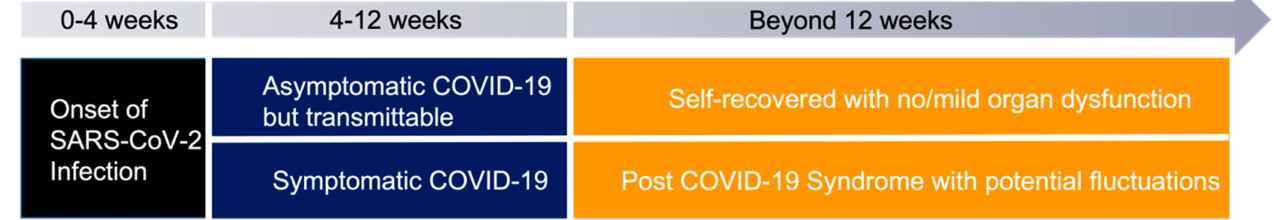
Figure 1. Proposed Pathogenesis model of PC19S